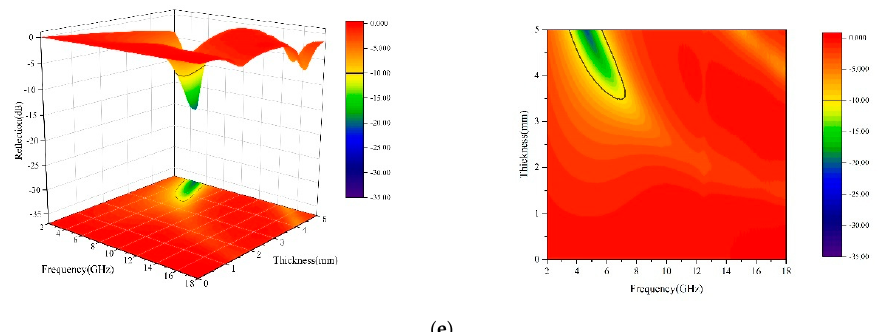
Figure 8. Three-dimensional reflectivity graphs of the Fe 3 O 4 absorption materials at different ball milling times. ( a ) Ball milling for 0 h; ( b ) Ball milling for 0.5 h; ( c ) Ball milling for 1 h; ( d ) Ball milling for 1.5 h; ( e ) Ball milling for 2.0